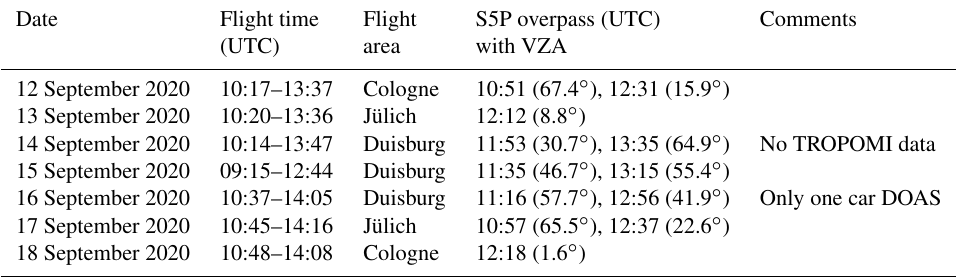
Table 1. List of the aircraft activities, including S5P overpass information. All times are in UTC. On days with two S5P overpasses over the area, flights were arranged to coincide with the overpass at smaller VZA of